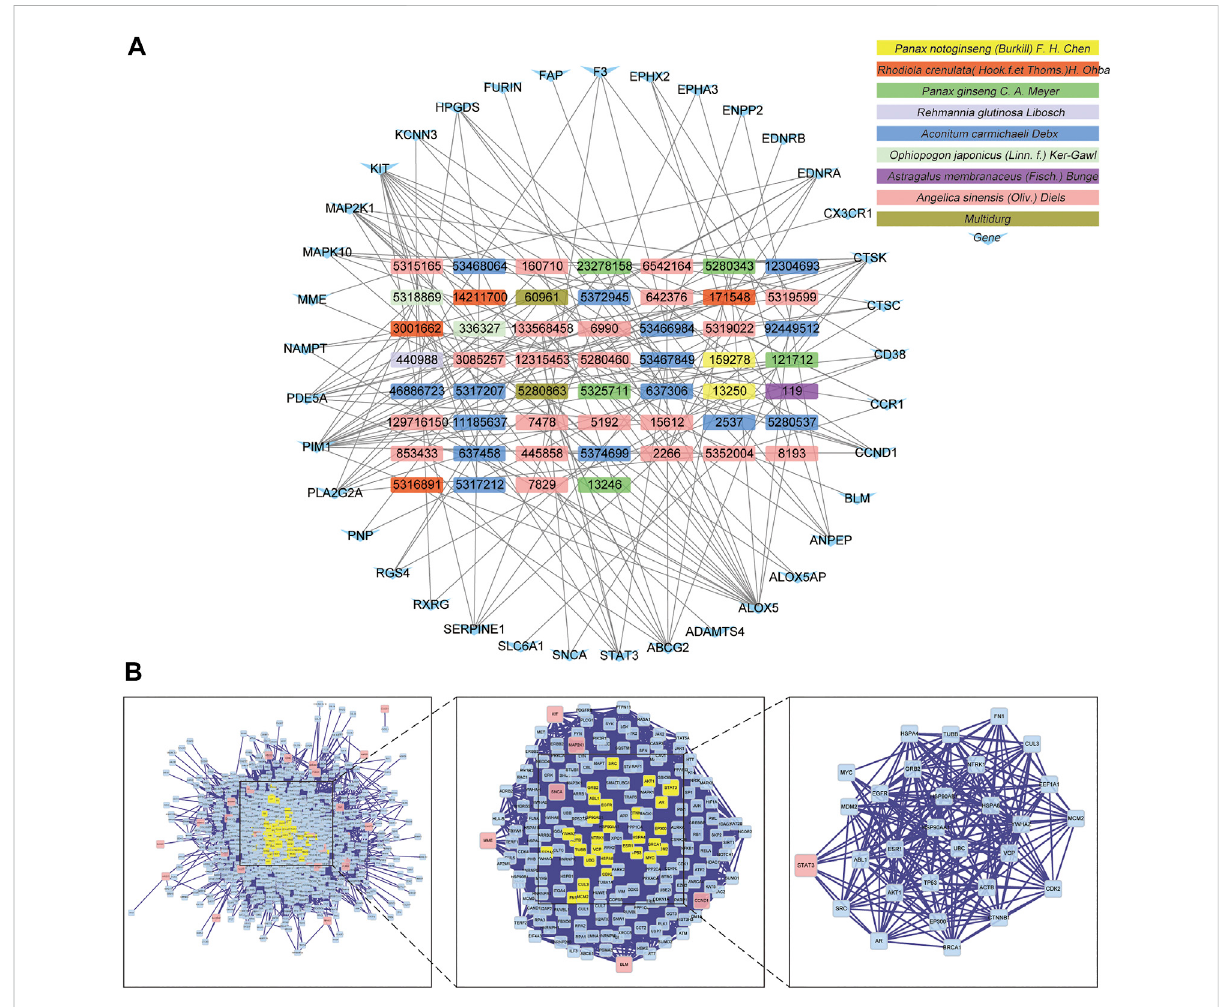
FIGURE 2 Regulatorynetwork and PPI network. (A) Herb-ingredients-targets network. (B) PPI network and its topological analysis. The initial PPI network of 37 intersection genes had 1,260 nodes and 18,091 edges, whereas the fi nal network included 29 nodes and 243